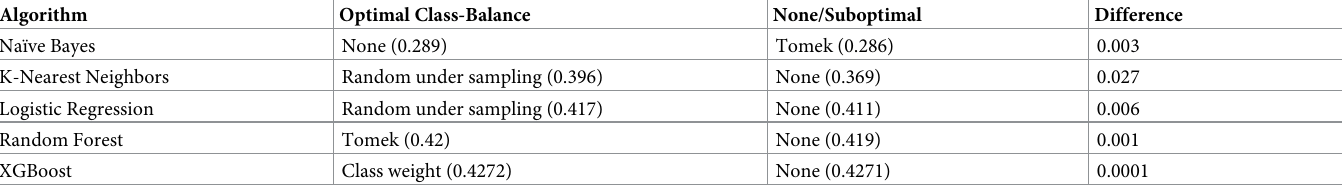
Values in parenthesis represent the mean ANSA values over cross-validation folds. The far-right column indicates the difference in mean ANSA reported in the second and third